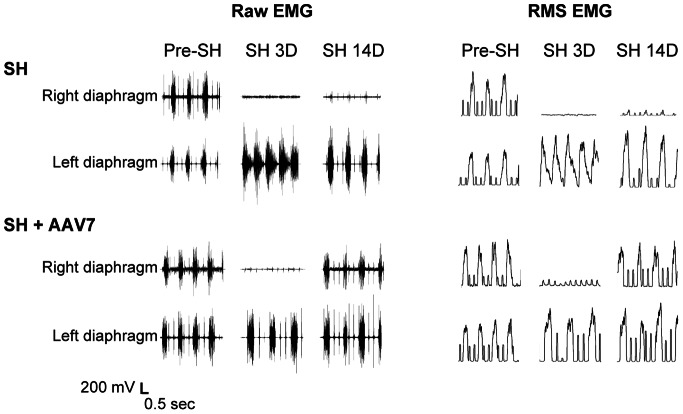
Representative raw diaphragm EMG recordings and root mean squared (RMS) EMG tracings after SH.Untreated SH animals (SH; n = 8) and SH animals treated with intrapleural AAV7-TrkB.FL (SH+AAV7; n = 11) were chronically monitored using EMG recordings obtained via implanted diaphragm electrodes during eupnea. EMG was recorded prior to (pre-SH) and at 3 days (SH 3D) and 14 days post-SH (SH 14D). Diaphragm EMG activity was absent in all animals at SH 3D, confirming complete interruption of descending ipsilateral drive to phrenic motoneurons and resulting diaphragm muscle paralysis. Both ipsilateral and contralateral diaphragm EMG activity occurred in bursts, reflecting rhythmic inspiration in the anesthetized animals. Contralateral diaphragm RMS EMG amplitude increased at SH 14D in both untreated SH and AAV7-TrkB.FL treated SH animals compared to pre-SH EMG activity. In both of the groups, there was a lack of baseline, non-rhythmic EMG activity suggestive of spasms or tonic activity in either side of the diaphragm at any time point post-SH. Intrapleural AAV9-TrkB.FL treated animals (n = 3) displayed qualitatively similar results to the untreated SH group and are not shown.